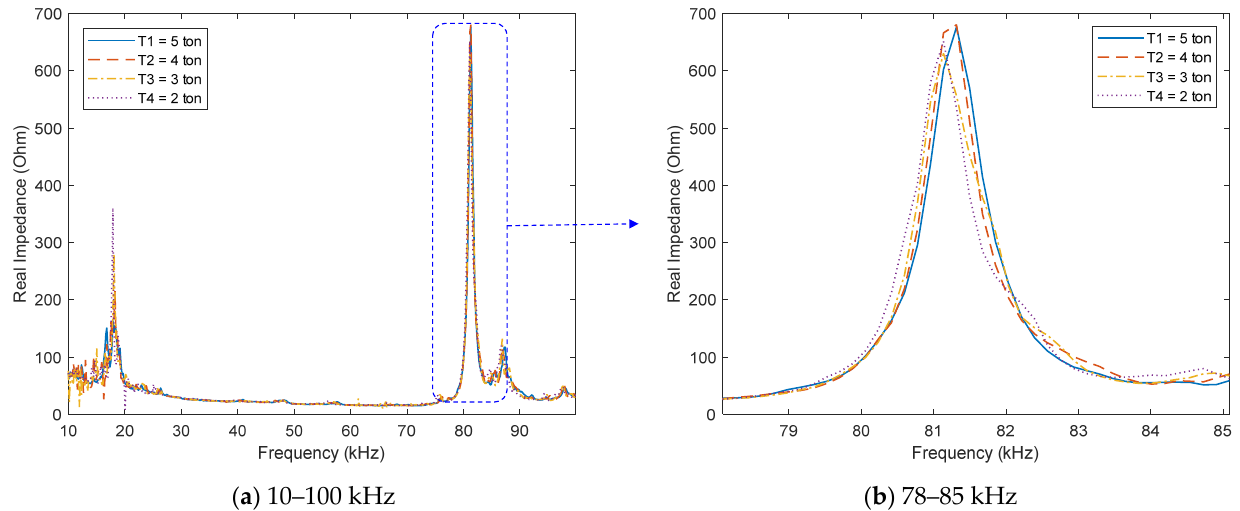
Figure 12. Real electromechanical impedance responses of the two-point mount PZT interface.